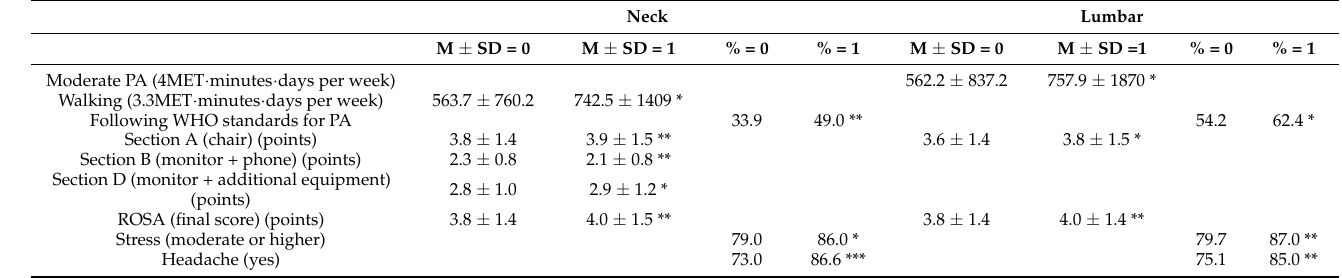
Table 3. Comparison of lifestyle parameters, health aspects and computer workstation features in subgroups of people with and without complaints in the neck region or lumbar spine during the pandemic (only statistically significant differences are